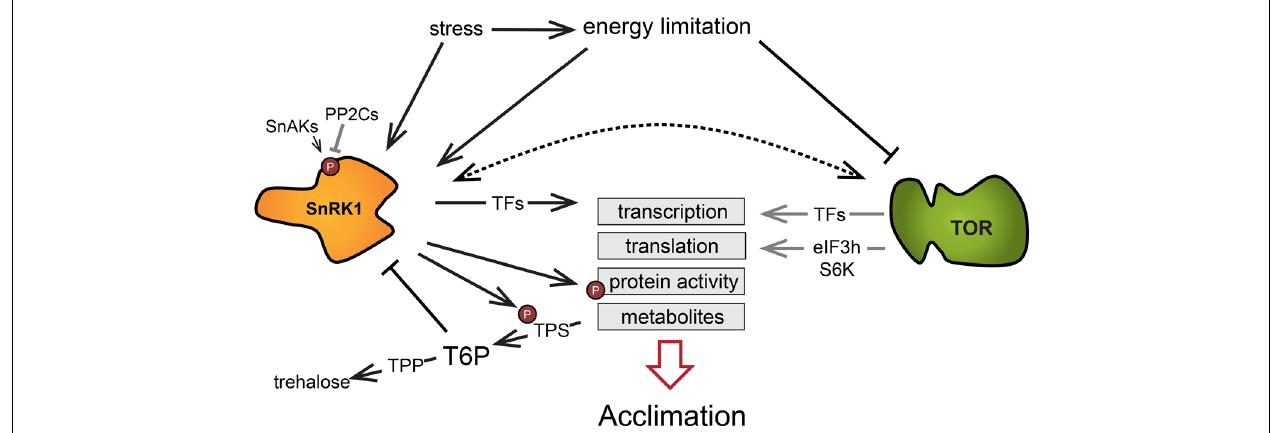
and the dashed arrow denotes a probable interaction between these two signaling pathways. Abbreviations: SnAK, SnRK1-activating kinase; PP2C, type 2C protein phosphatase; TPS, trehalose phosphate synthase; T6P, trehalose 6-phosphate; TPP, trehalose phosphate phosphatase; eIF3h, eukaryotic translation initiation factor 3 subunit H; S6K, ribosomal protein S6